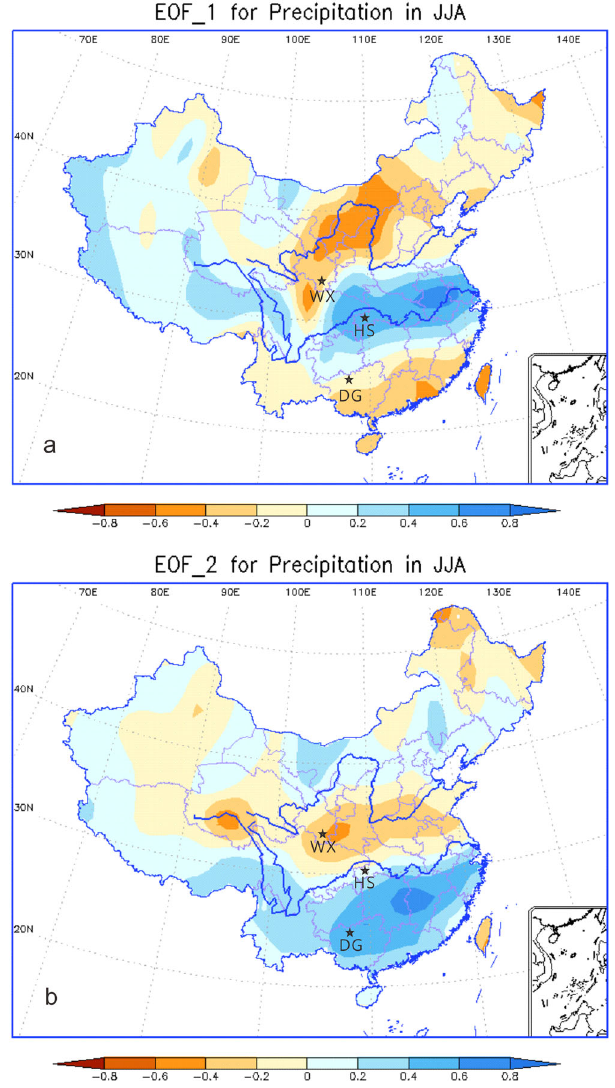
Fig. 1 The rainfall spatial distribution structures in eastern China from 1951 to 2012 CE. The tripole rainfall pattern presents anti-phased changes between central China and northern and southern China ( a ). The dipole rainfall pattern re fl ects the anti-phased change between southern and northern China ( b ). The stars mark the cave locations of Dongge 29 , Heshang (this study), and Wanxiang 28 , where three high-resolution stalagmite δ 18 O records come from. We added the research sites on the base map from ref. 35